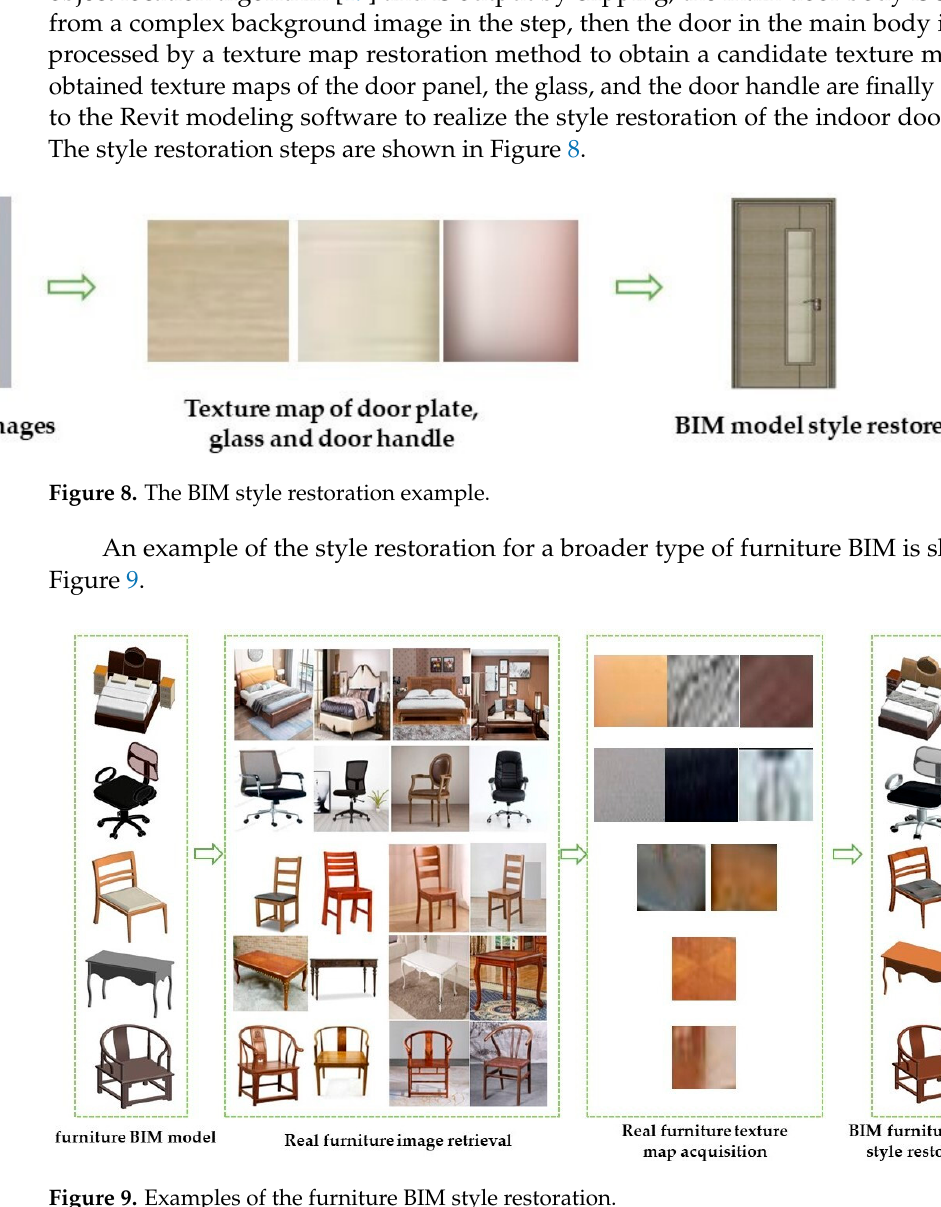
Figure 9. Examples of the furniture BIM style restoration.